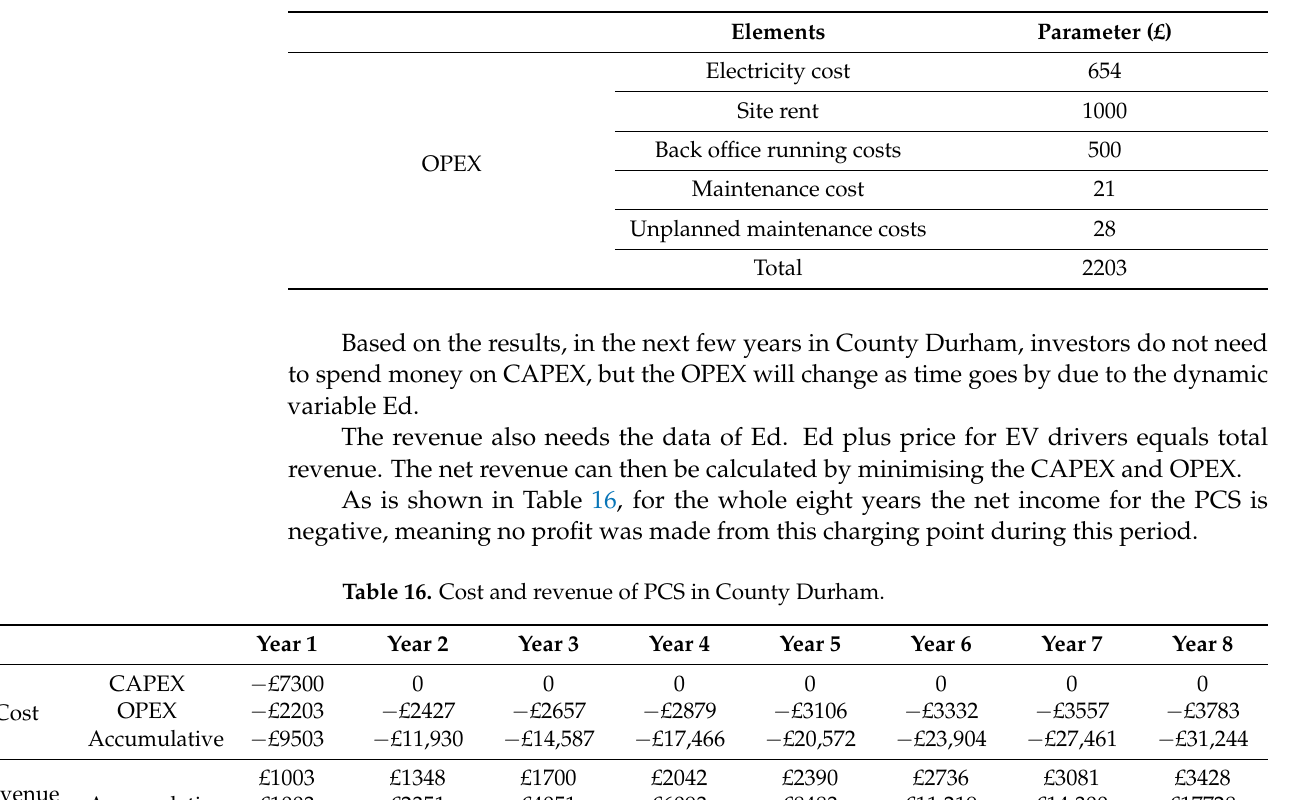
Table 15. OPEX analysis of County Durham (Year 1).